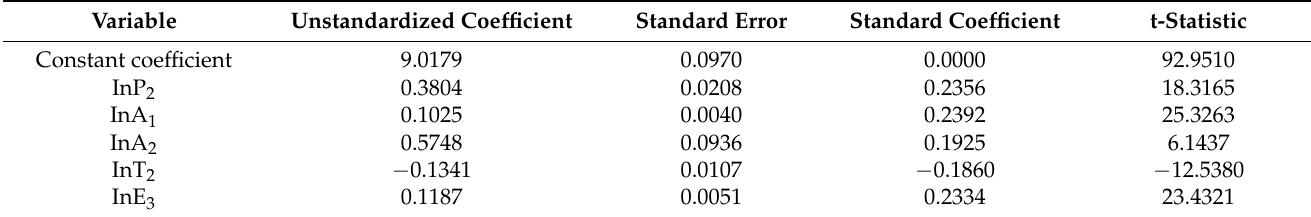
Table 5. Anhui Model Test